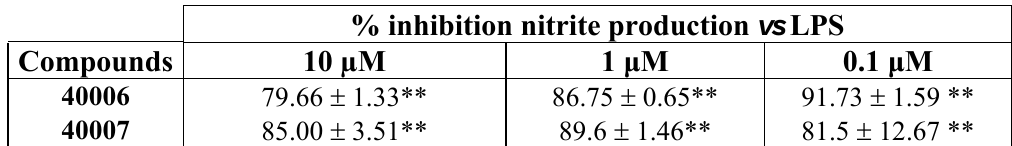
Table 3. Effect of compounds 40006 and 40007 on nitrite production by LPS- induced J774.A1 macrophages. Results are expressed as mean ± S.E.M. % inhibition calculated versus nitrite produced by J774.A1 treated with LPS alone of at least 3 independents experiments with three replicates each. Comparison was performed using one way analysis of variance. ** P < 0.01 vs. LPS.